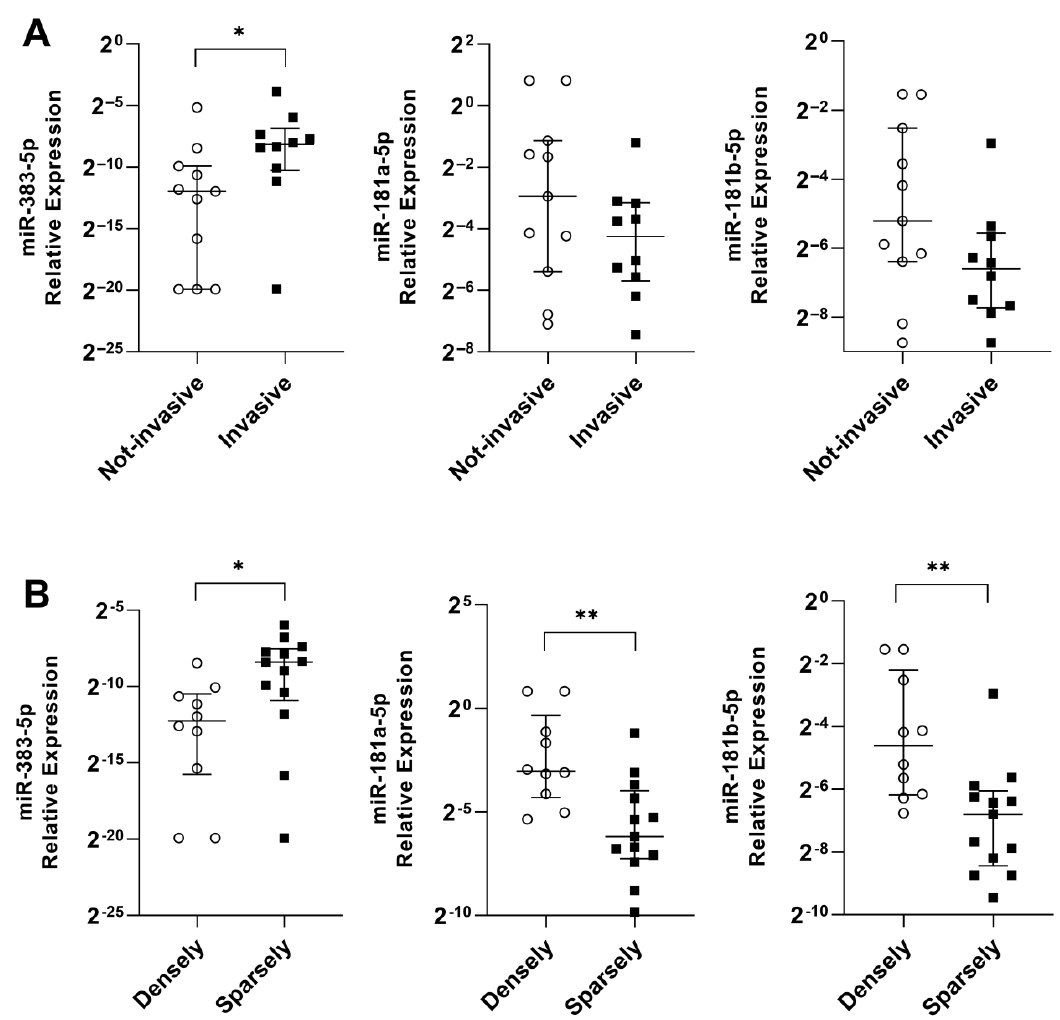
Figure 5. miR-383-5p, miR-181a-5p, and miR-181b-5p and tumor characteristics. ( A ) miRNAs’ relative expression in noninvasive x invasive tumors. ( B ) miRNAs’ relative expression in densely granulated tumors x sparsely granulated tumors. On the y -axis, the relative expression is scaled by Log2. *: p < 0.05; **: p < 0.005.